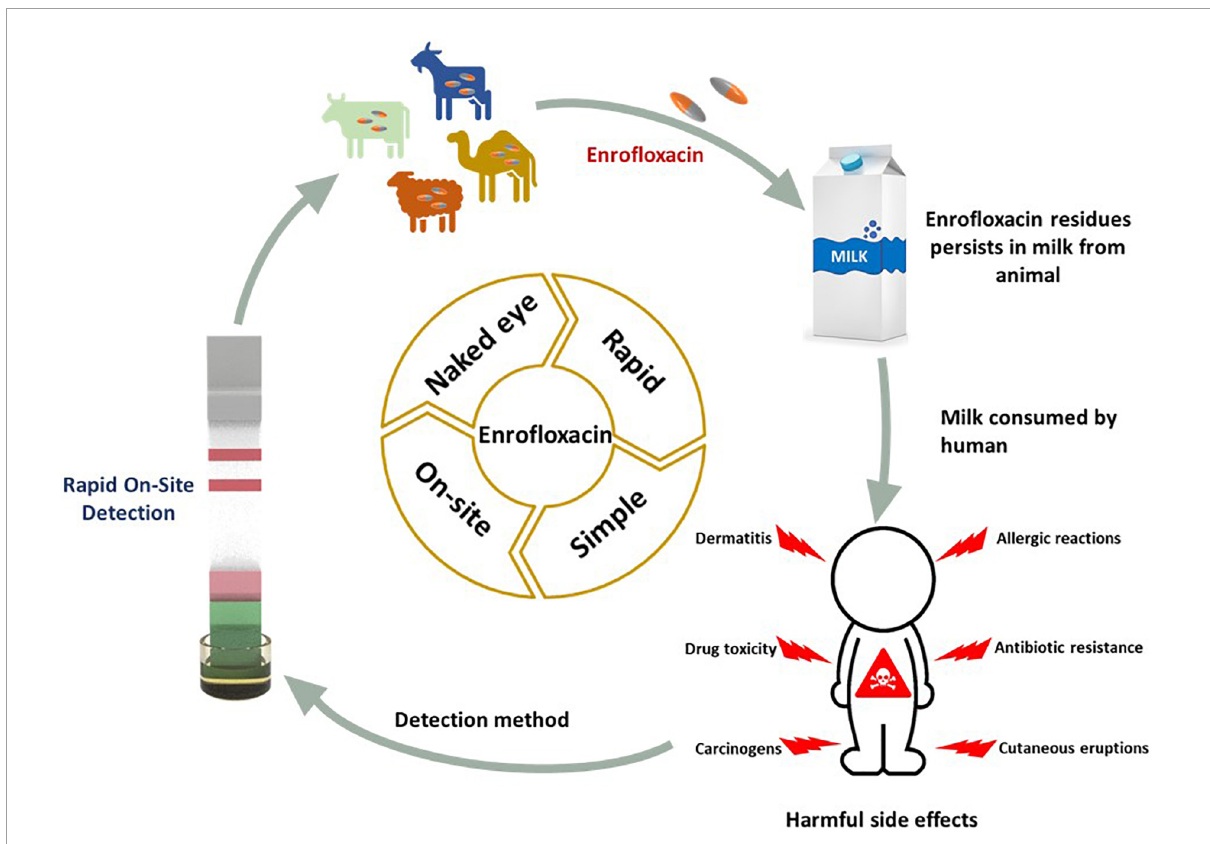
GRAPHICALABSTRACT Rapid on-site detection of enrofloxacin in